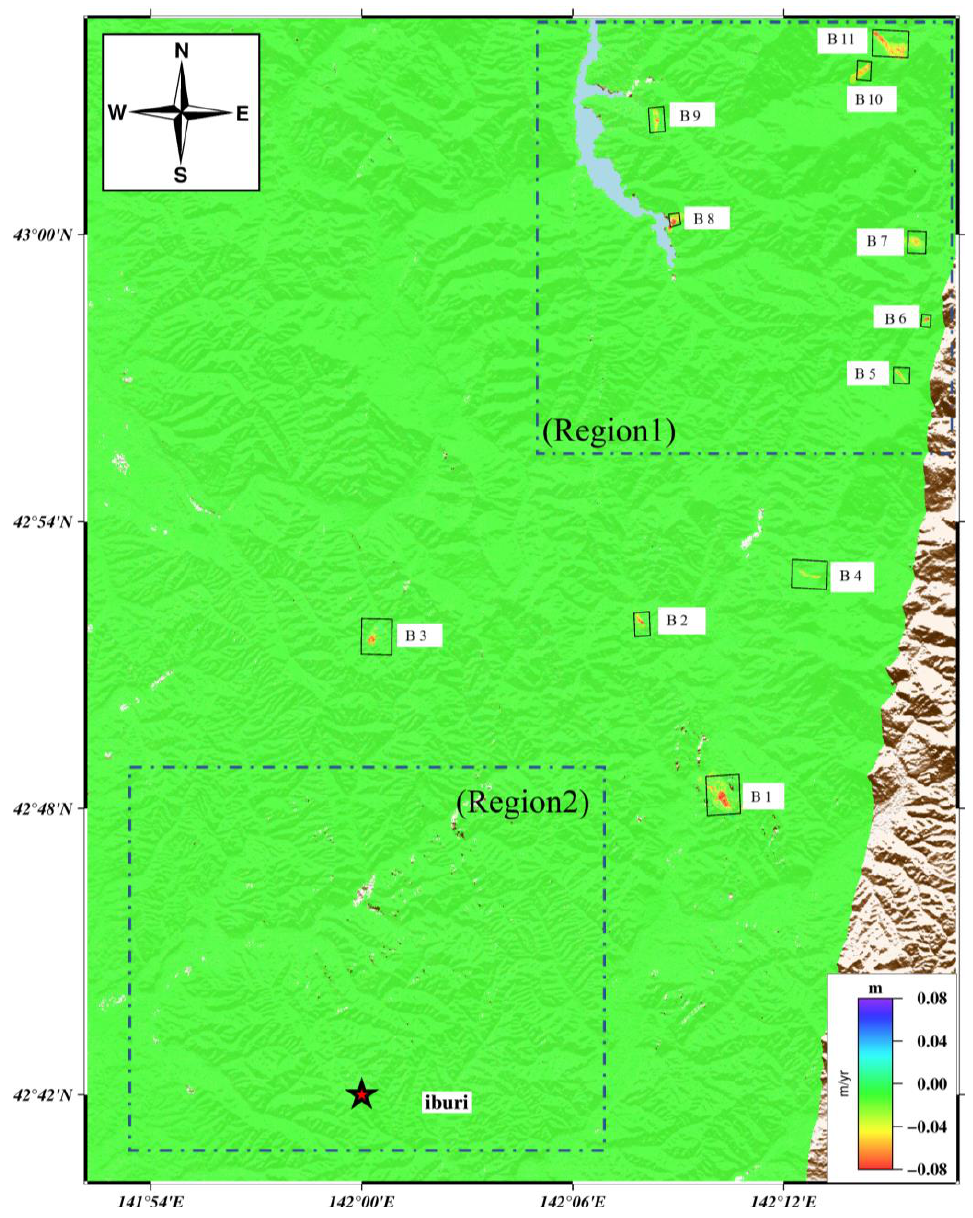
Figure 7. Distribution map of the monitored slow-moving landslides before the earthquake. The average pre-earthquake deformation velocity in the Iburi area is derived from the ALOS-2 PALSAR-2 data, and the black boxes indicate the locations of the slow-moving landslides. B1–B11 represent the slow-moving landslides detected in the pre-earthquake period. Table 2. Lithological parameters 1 .